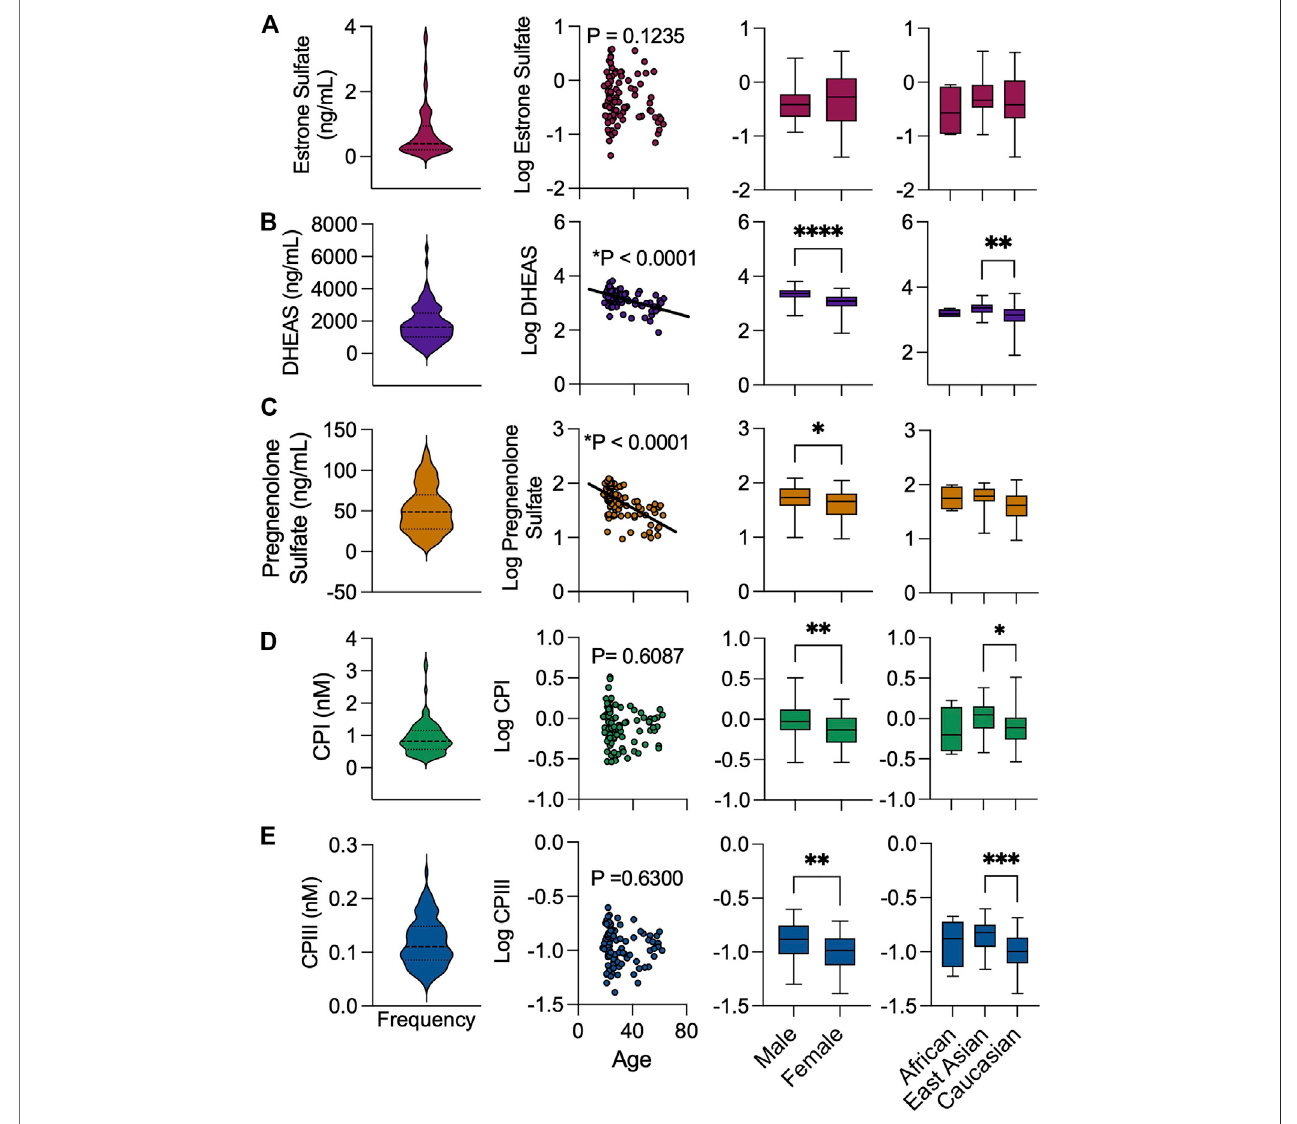
FIGURE 4 | Cohort distribution of endogenous biomarkers levels by baseline demographics. Frequency distribution of (A) estrone sulfate, (B) DHEAS, (C) pregnenolone sulfate (D) CPI and (E) CPIII. Association of endogenous substrates with age, sex, and ethnicity. Box and whiskers plots are shown as mean (line), 25th and 75th percentile (box) and range (whiskers) * p < 0.05, ** p < 0.01, *** p < 0.001, **** p < 0.0001.